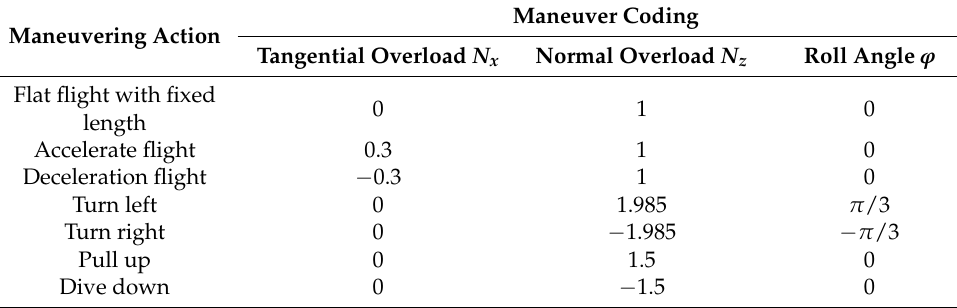
Table 1. Instruction analysis of basic air combat